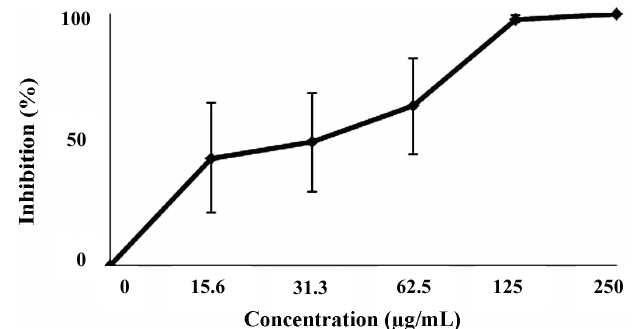
The data points represent the median of three experiments ± SD. Each set of experiments was repeated